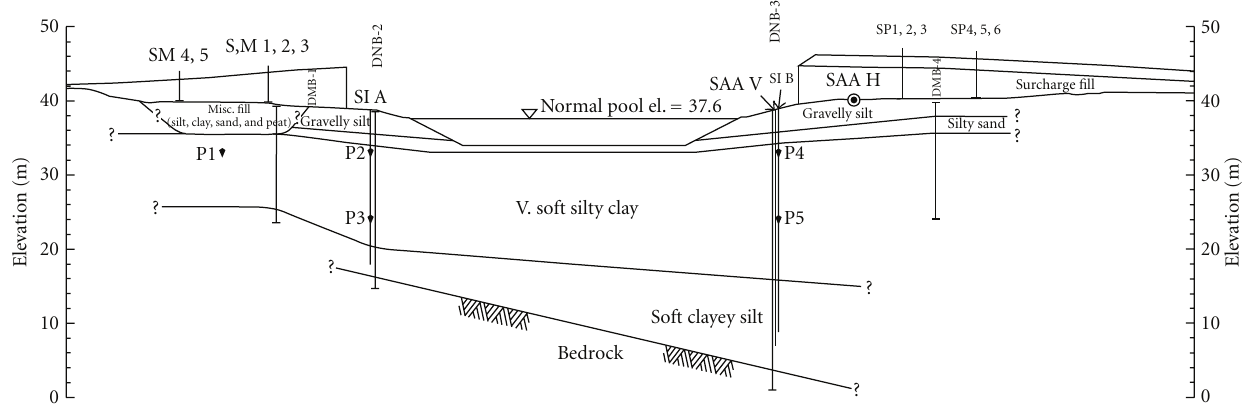
Figure 5: Soil profile and location of vertical SAA at Champlain Canal